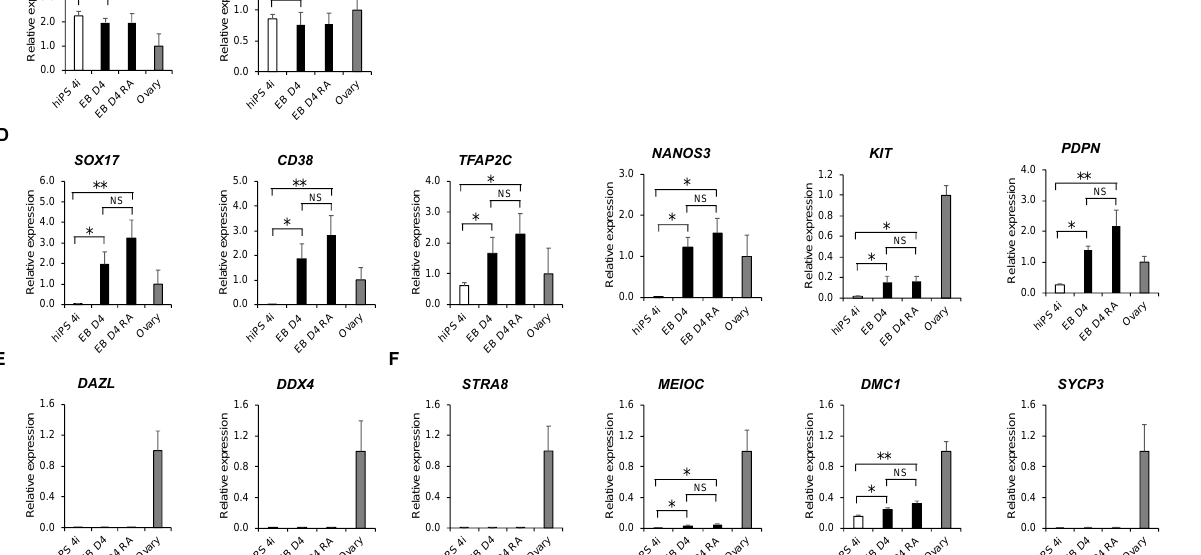
germ layers, scores for lineage-specific gene lists were computed (Figures 2A,B and